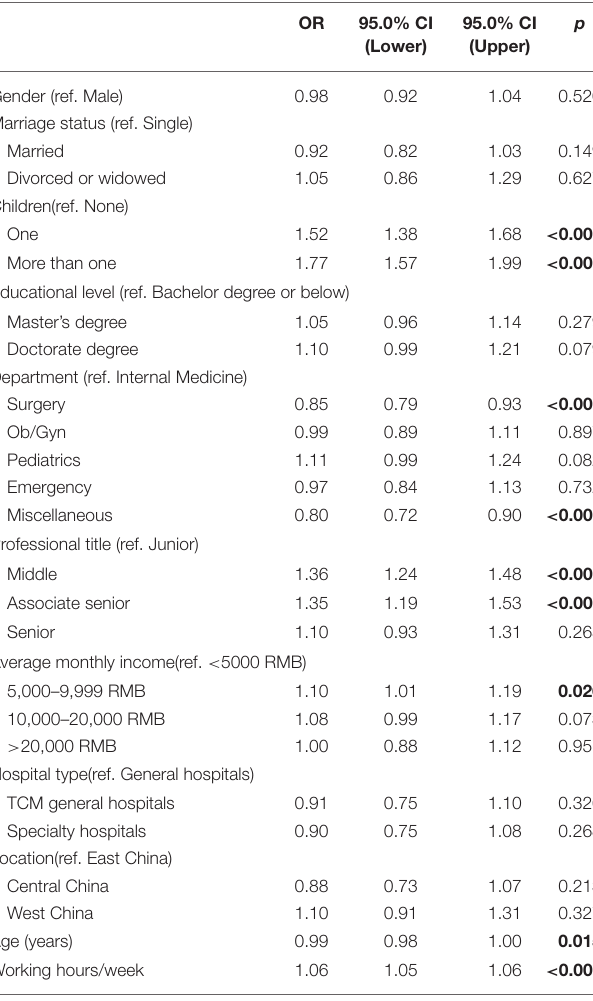
TABLE 4 | Univariate analysis of WLB. TABLE 5 | Multi-level Logistic regression examining factors associated with WLB (Dissatisfied WLB vs. non-Dissatisfied WLB).